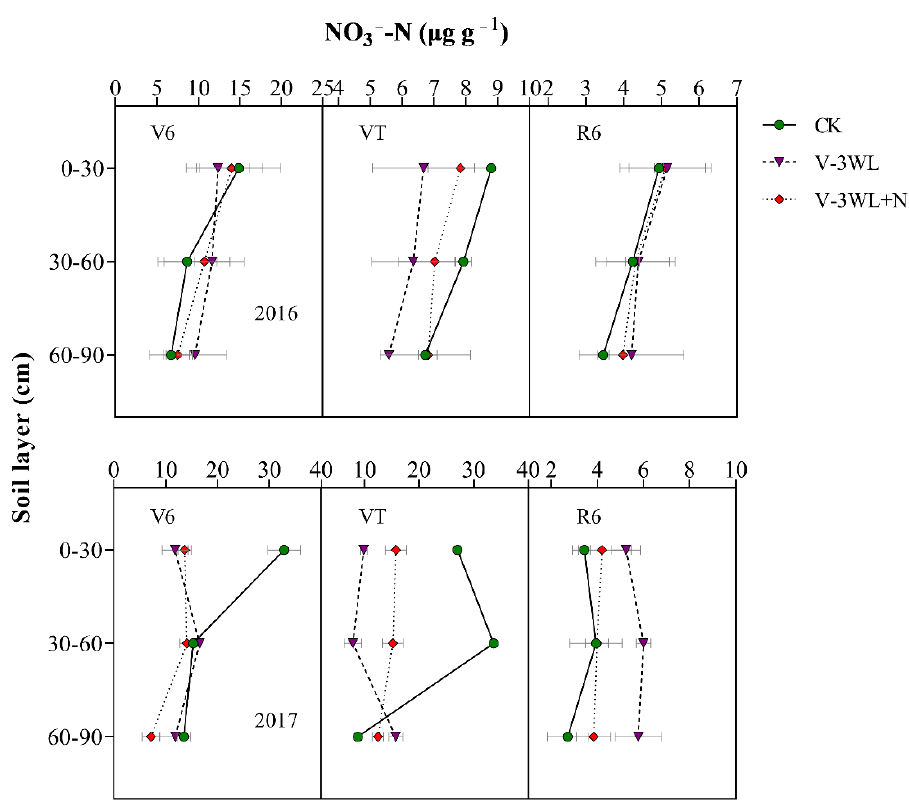
Figure 3. Effects of applying nitrapyrin on the soil NO 3 − -N content in a waterlogged maize field. V-3WL, waterlogging treatment with urea application only; V-3WL+N, waterlogging treatment with urea and nitrapyrin application; CK, not waterlogged, but applied only urea. The error bars represent 95% confidence intervals.